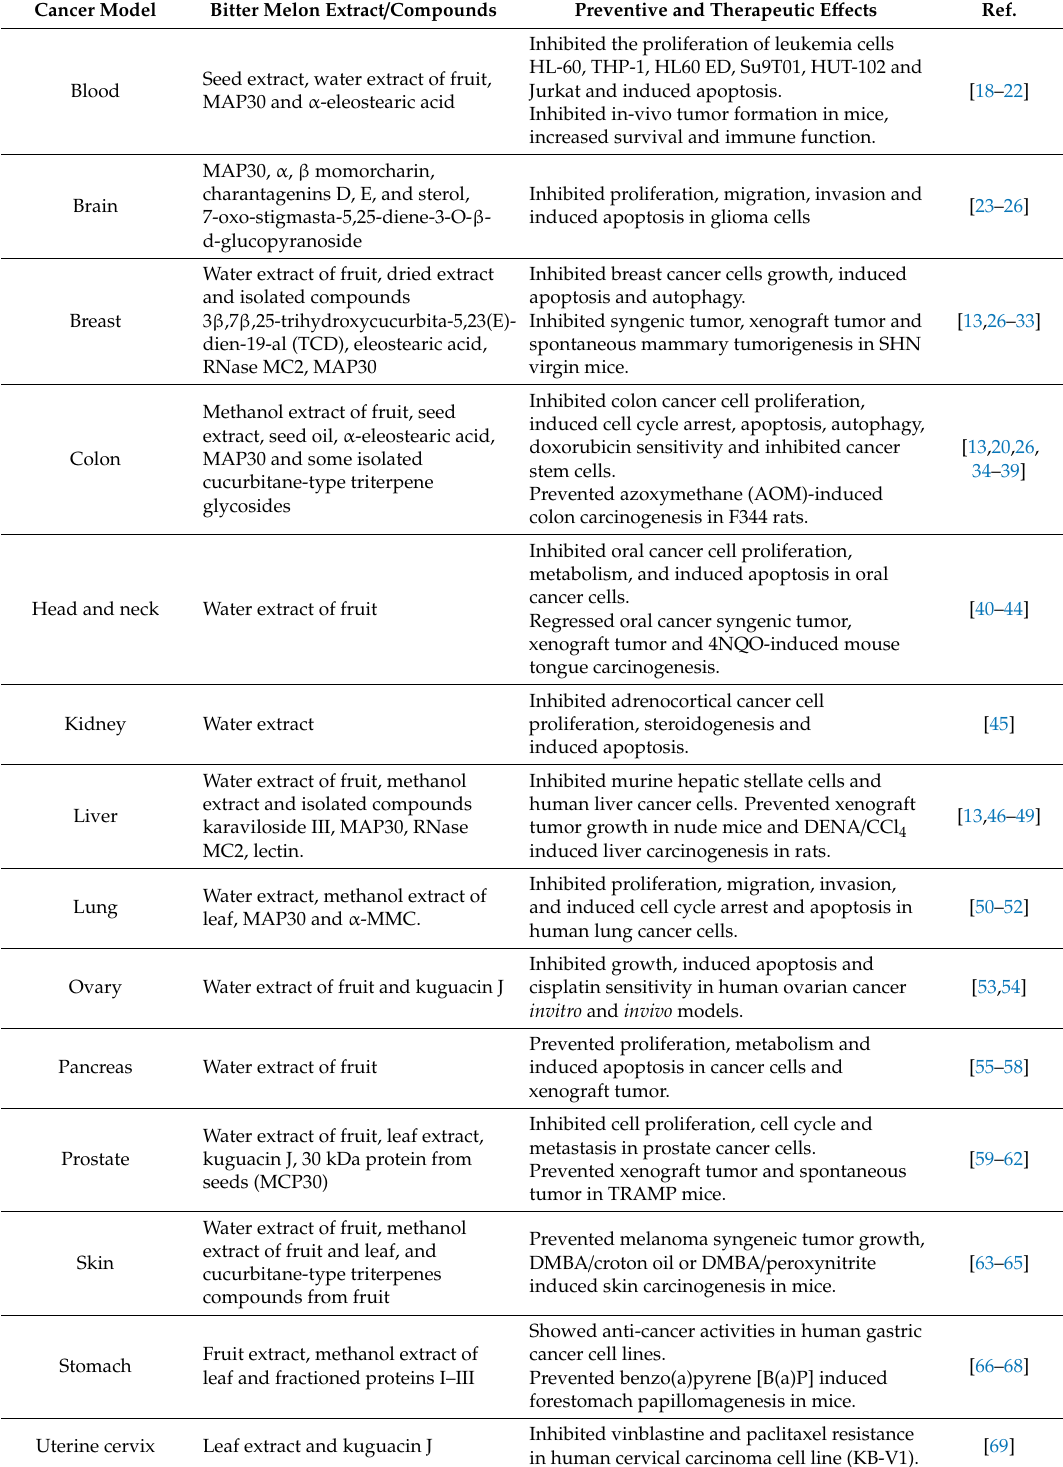
Table 1. Roles of bitter melon in cancer prevention and